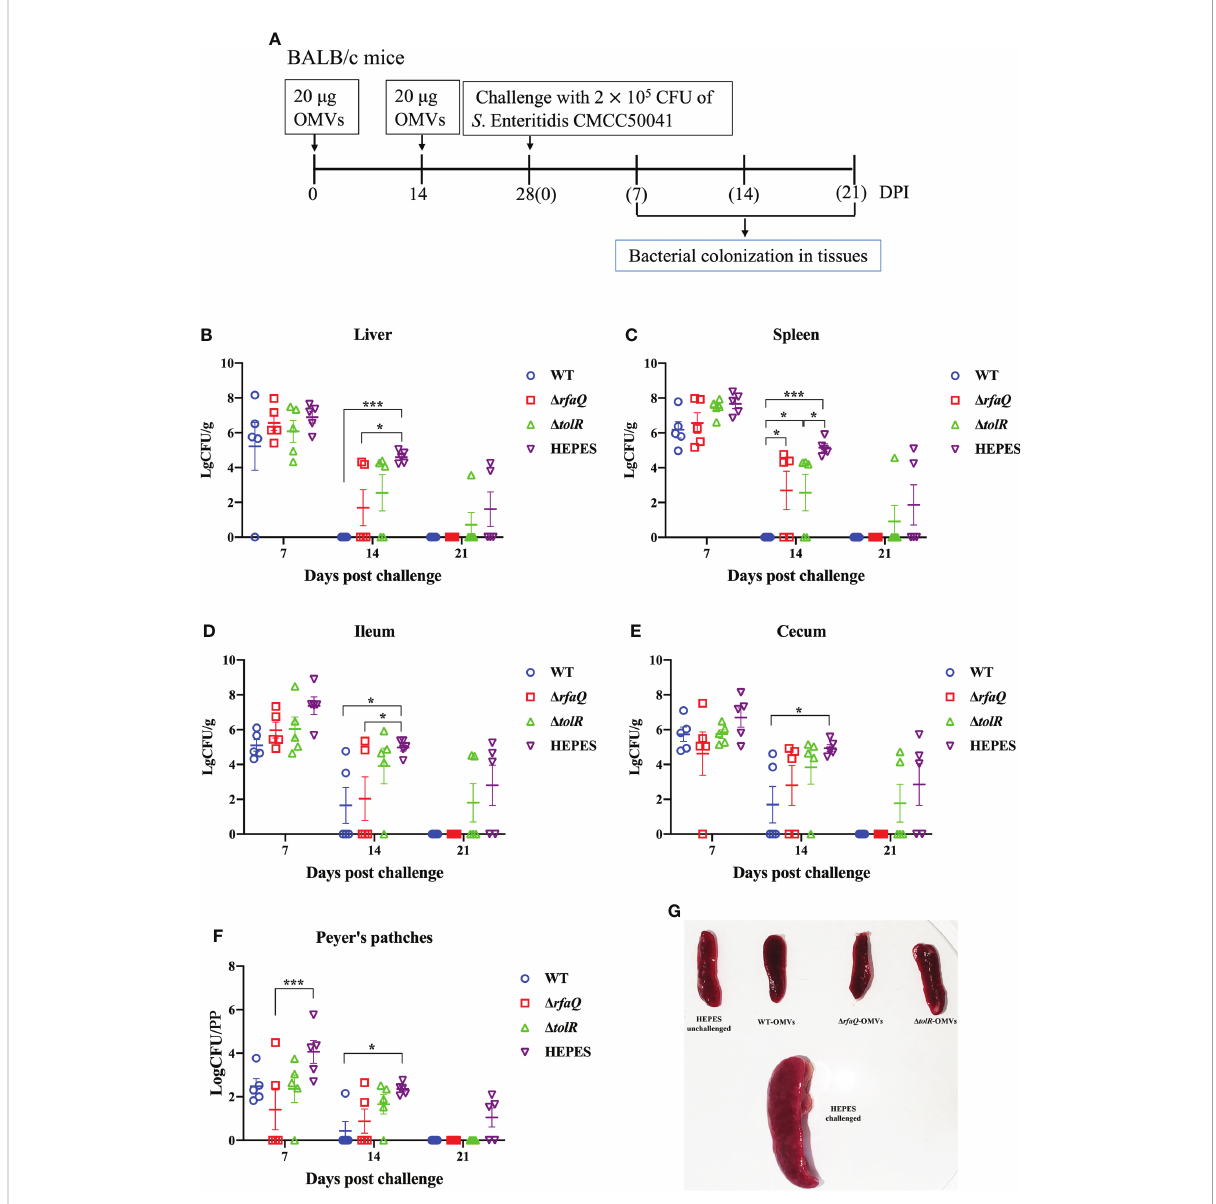
FIGURE 5 Eradication of S. Enteritidis colonization in mice. BALB/c mice were immunized with OMVs and challenged with the CMCC50041 strain (A) . Bacterial colonization in the liver (B) , spleen (C) , ileum (D) , cecum (E) and Peyer ’ s patches (F) was assessed using log CFU/g or log CFU/PP (for Peyer ’ s patches). Spleen swelling was assessed for comparison among the groups (G) . Data are expressed as the mean ± SEM. * p ≤ 0.05; *** p ≤